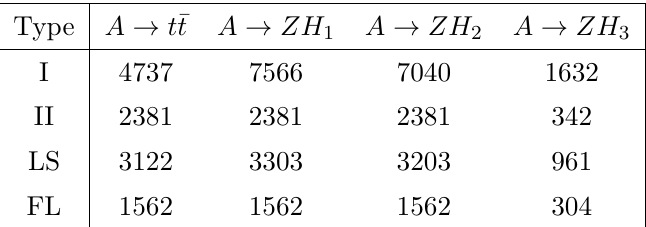
Table 27 . Number of parameter points available for the analysis in the individual OS decay channels of A ( H 2 is